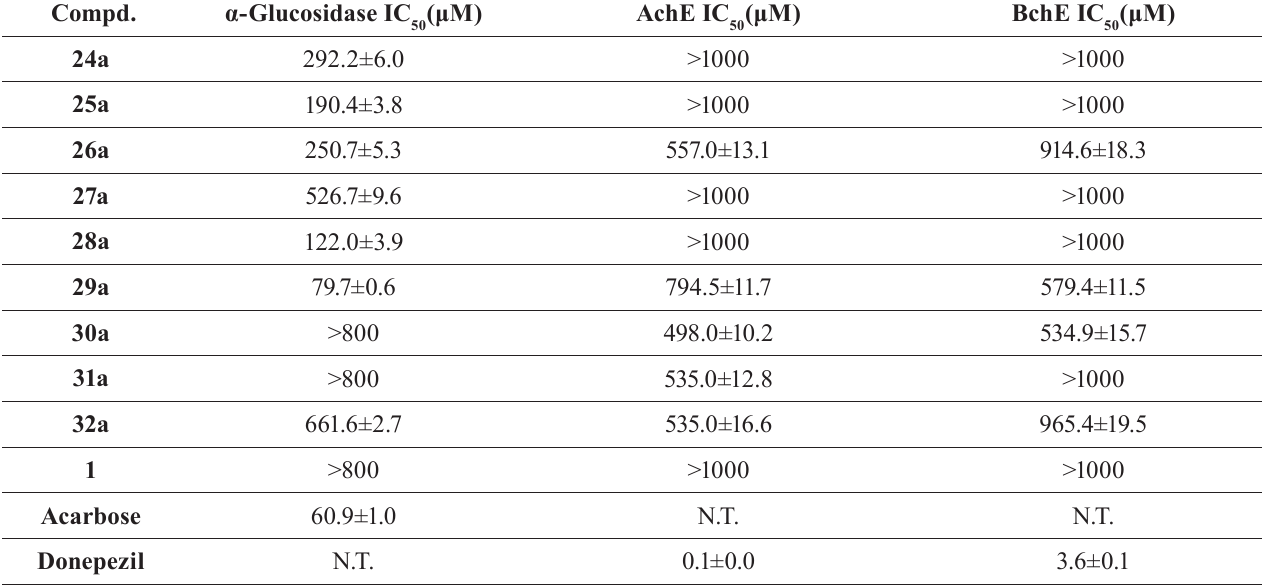
TABLE II - Hypoglycemic activity, anticholinesterase activity of compounds 3a-32a